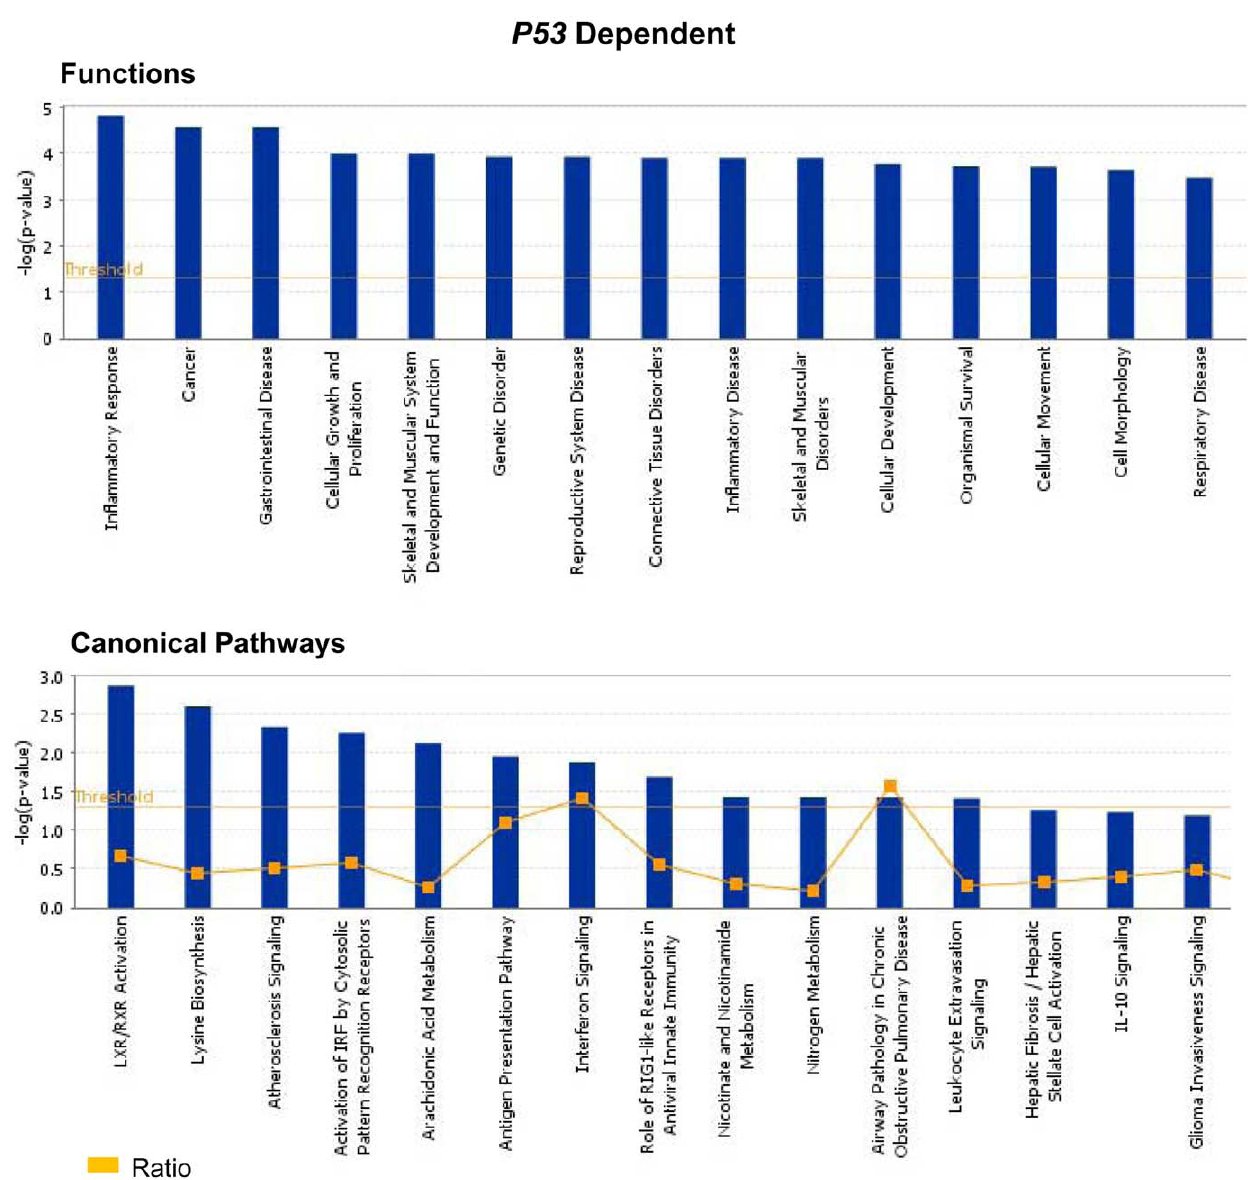
Figure 5. Ingenuity Pathway Analysis (Ingenuity Systems, Inc) of the genes that were regulated by Mta1 in the presence of P53 was performed. The significance of each function or canonical pathway is determined based upon the p- values determined using Right tailed Fisher’s exact test and with threshold less than 0.05. The top 15 possible functions and canonical pathways of the genes regulated by Mta1 in P53 dependent manner are shown. Ratio of number of genes in a given pathway satisfying the cutoff and total number of genes present in that pathway was determined by IPA.